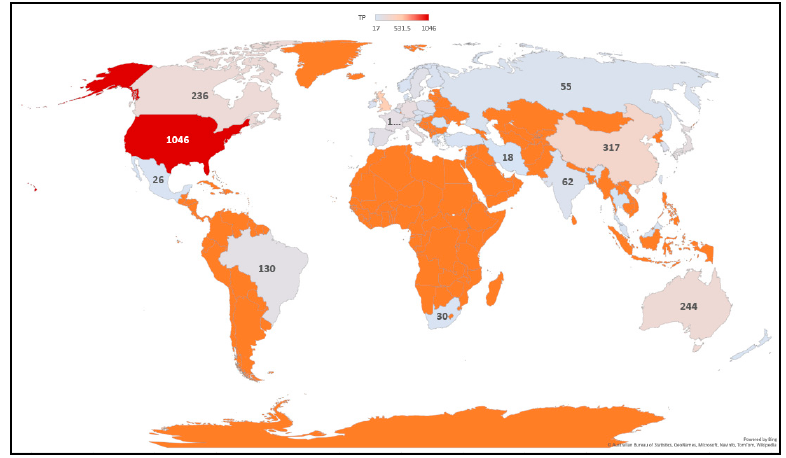
Figure 4. Geographical distribution of publications.